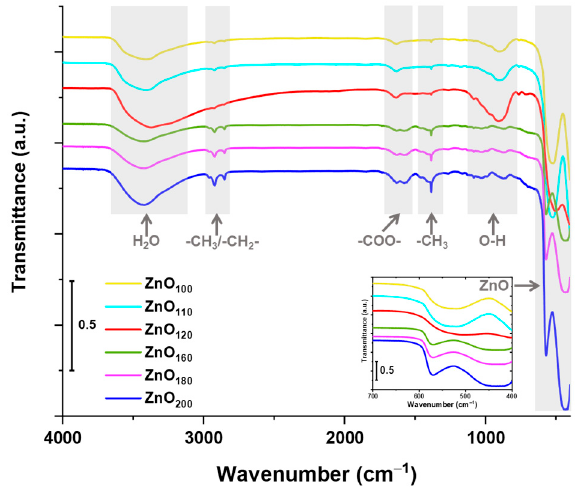
Figure 4. FT-IR spectra of ZnO x particles synthesized hydrothermally at a temperature in the range of 100–200 °C, where x subscripts indicate the exact temperature of synthesis.